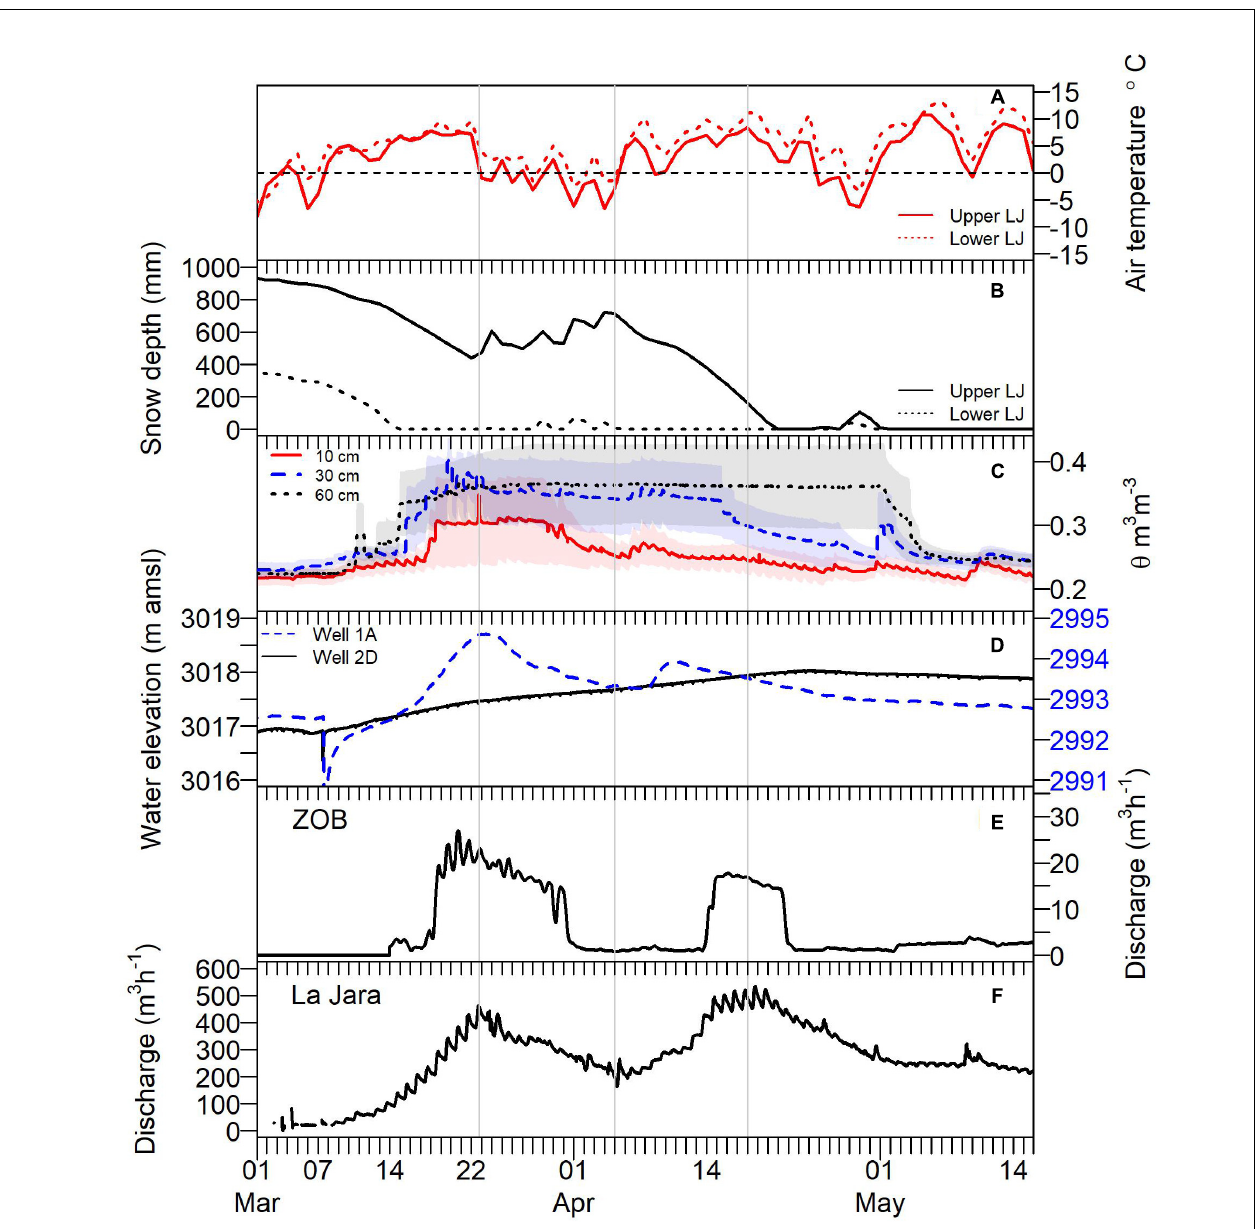
FIGURE 2 | Time series of hydrometeorological data: (A) air temperature and (B) snow depth at Redondo peak and Headquarters meteorological stations (C) mean (lines) and standard error (shaded) volumetric soil water content as a function of depth in ZOB, (D) groundwater elevation Well 1A (right axis) and Well 2D (left axis), respectively, and surface water discharge for (E) ZOB and (F) La Jara flumes.